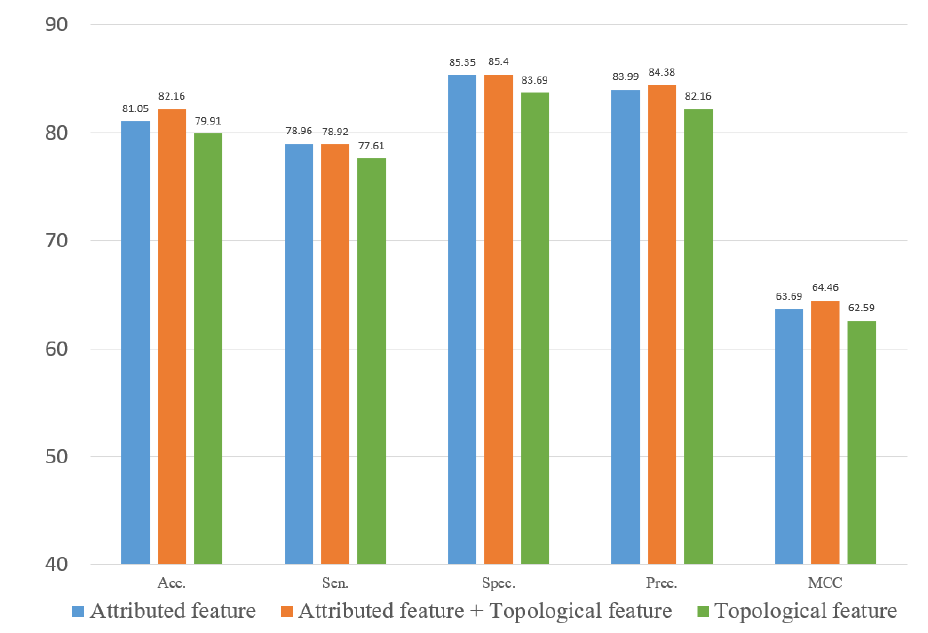
Figure 12. Result of ablation experiment on the SM2miR dataset.